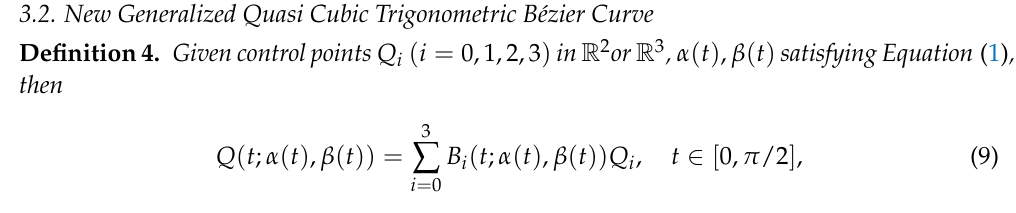
Figure 3. Some plots of the generalized quasi cubic trigonometric Bernstein basis functions with α ( t ) and β ( t ) given in Equation (8) and p = q =